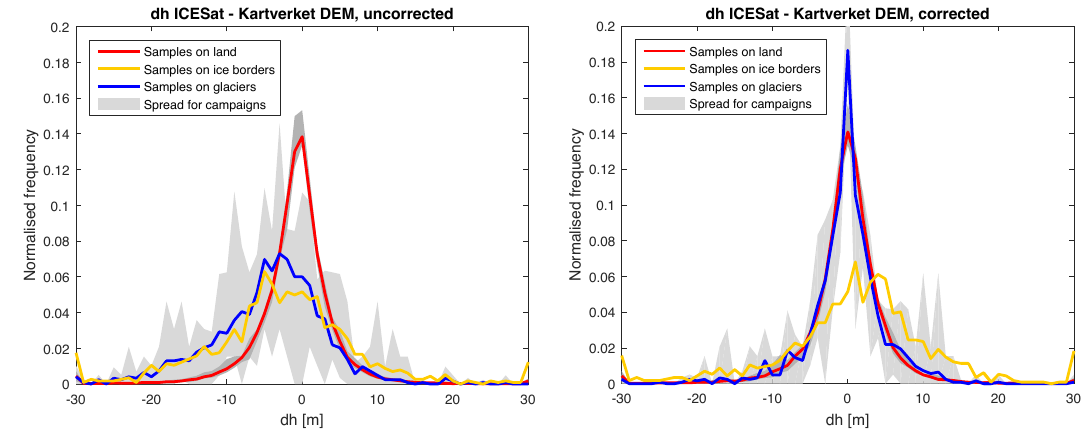
Figure 2. dh of land and ice (autumn campaigns 2003–2008) for the uncorrected Kartverket 10m DEM elevations (left) and with DEM elevation corrections ( c tile , c H ) and per-glacier correction ( c glac ) applied (right). The grey spreads shows the range of distributions for ice (wide spread, light grey) and land dh (narrow spread, darker grey) of individual